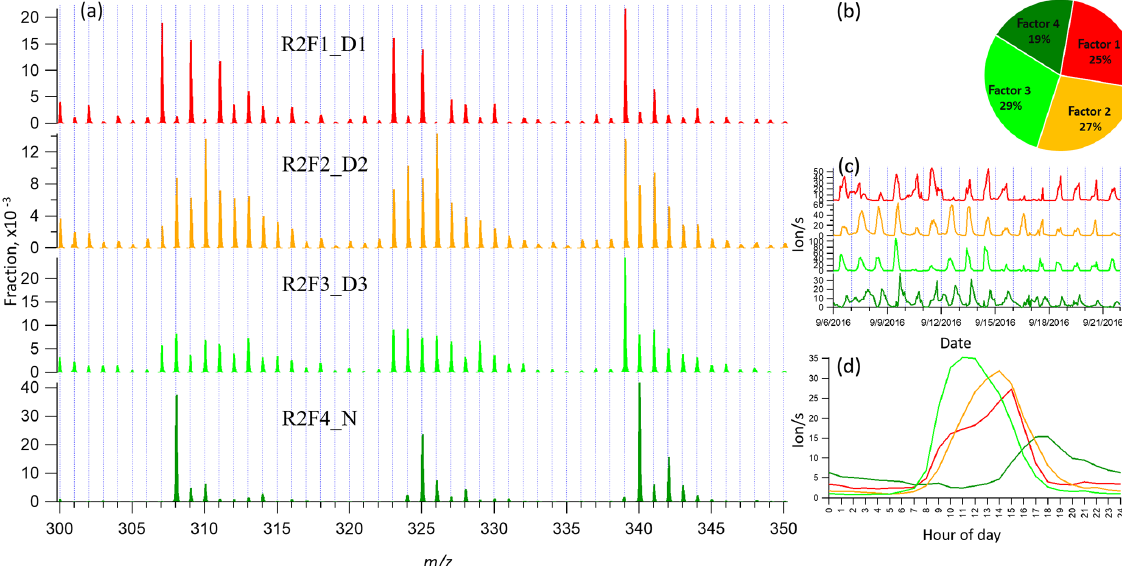
Figure 3. Four-factor result for Range 2 for (a) factor spectral profiles, (b) averaged factor contribution during the campaign, (c) time series, and (d) diurnal trend. Details on the naming schemes for the factors are shown in Table 1.